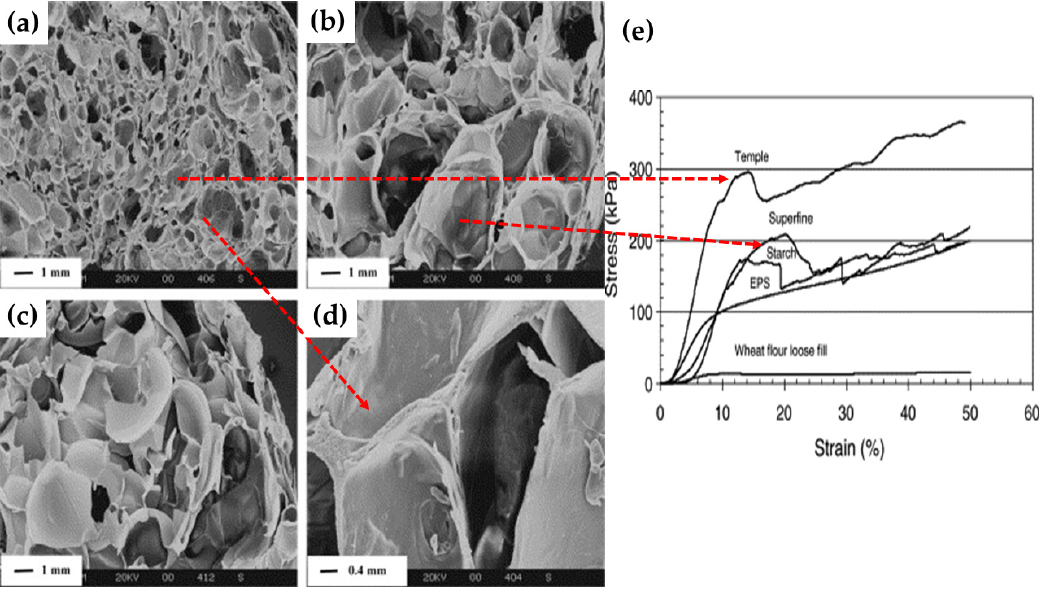
Figure 11. Scanning electron micrographs of cross-sections of foamed pellets with different raw materials: ( a ) temple flour, ( b ) superfine flour, ( c ) purified wheat starch, and ( d ) cell wall in temple foam shown in ( a ) at higher magnification. ( e ) Comparison of typical compressive stress–strain curves (22 ◦ C, 50% RH) for the microwave-foamed pellets made from di ff erent raw materials with commercial